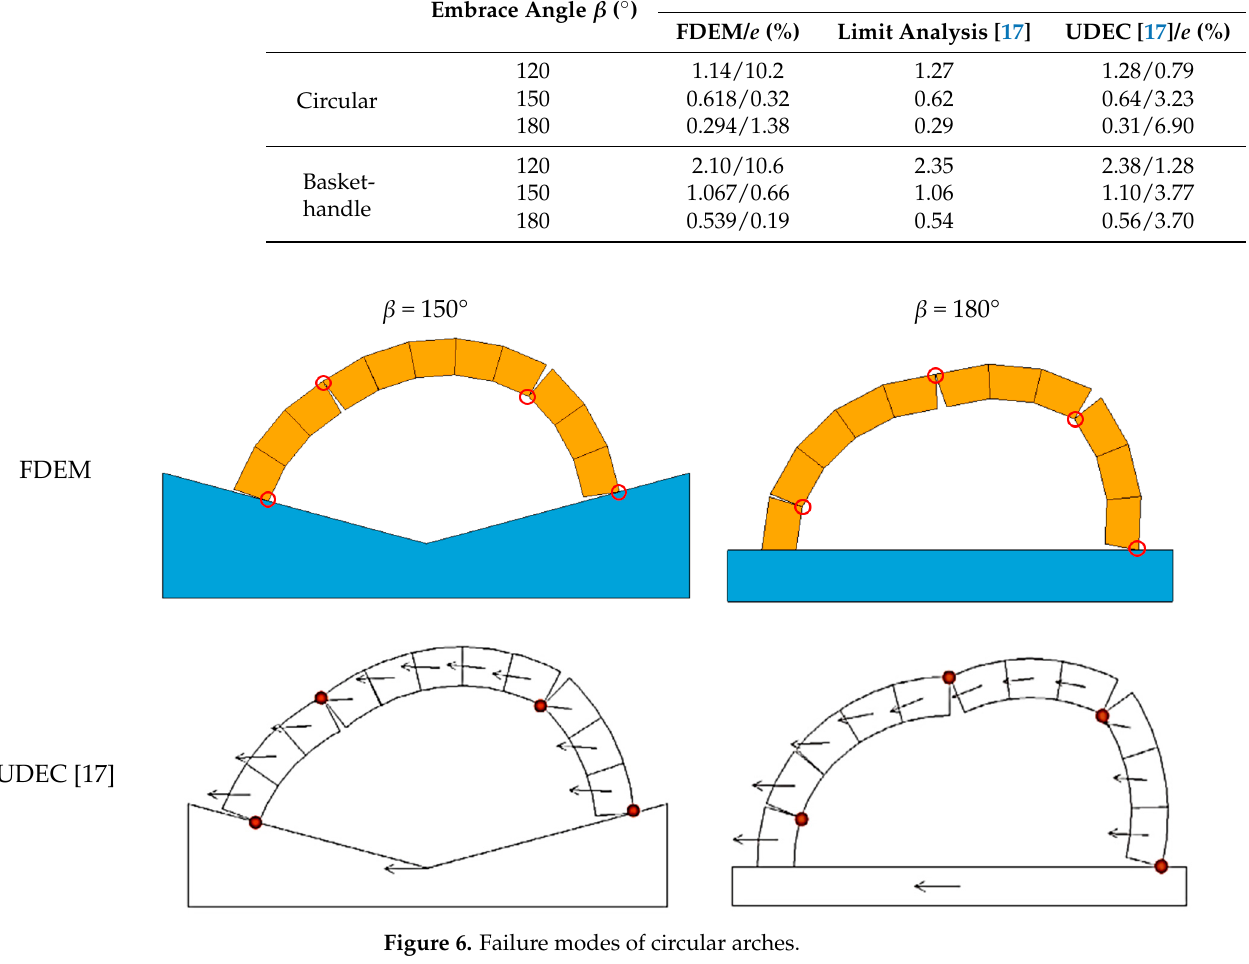
Figure 6. Failure modes of circular arches.